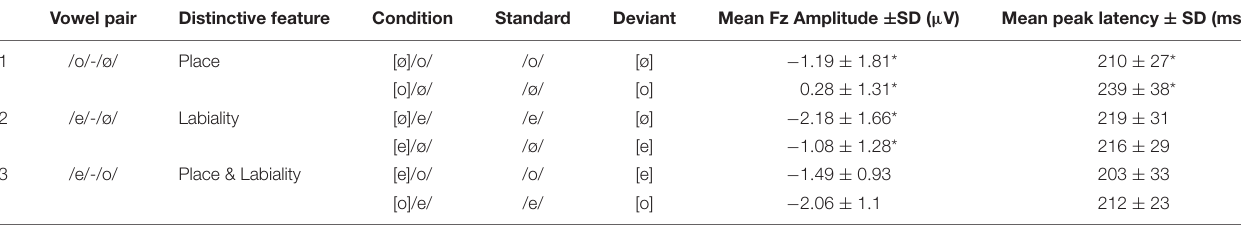
TABLE 2 | Table of results: MMN amplitude and peak latency at Fz for all six experimental condition.